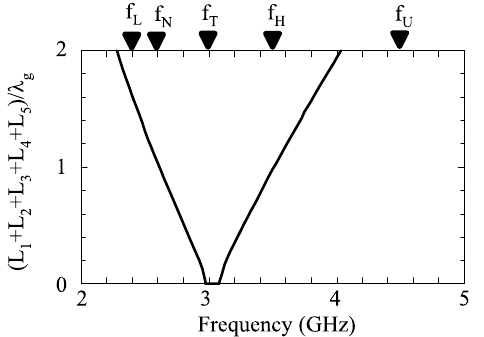
Fig. 3. Loop length L 1 + L 2 + L 3 + L 4 + L 5 normalized to guided wavelength l g , as a function of frequency. b < 0 at f < f T , b = 0 at f T , and b > 0 at f > f T .